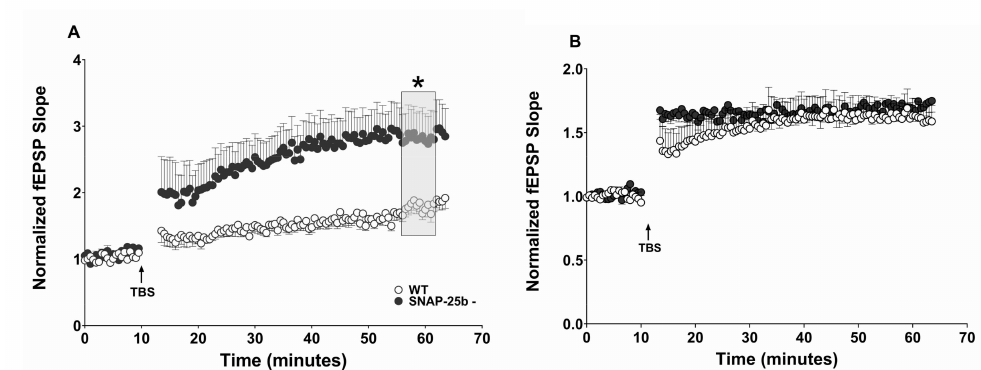
Figure 5. Hippocampal dependent training alters LTP in adolescent SNAP-25b-deficient mice of both sexes. ( A ): Time course of TBS (arrows) used to induce LTP in younger mice. After completing an active avoidance assay, adolescent mice lacking SNAP-25b showed enhanced LTP (filled circles, n = 7) relative to controls (open circles, n = 11). (* p < 0.01; Student’s t-test). Each point is normalized to the averaged baseline and is mean ± SEM of n slices; ( B ): TBS LTP (arrows) recorded from area CA1 in four month old mice that had completed a multiday active avoidance training. SNAP-25b-deficient mice (filled circles, n = 18) expressed LTP at levels similar to controls (open circles, n = 18). However, SNAP-25b deficient mice did show significantly larger PTP. Each point is normalized to the averaged baseline and is mean ± SEM of n slices.